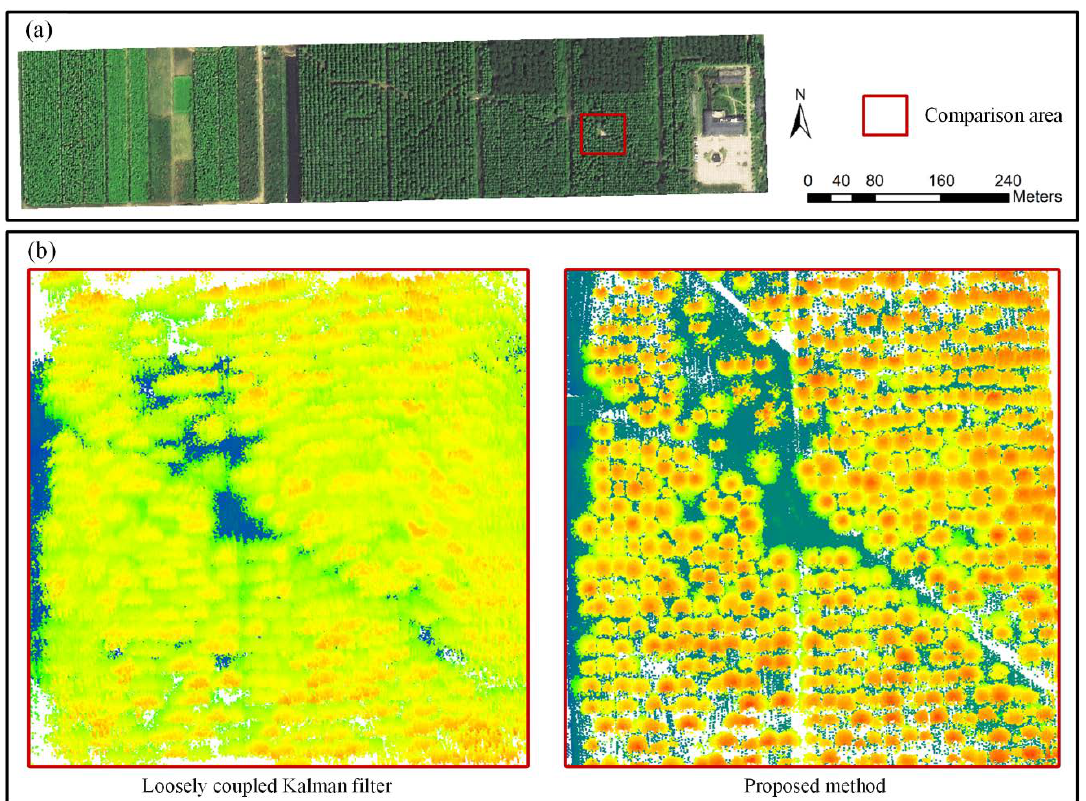
Figure 7. Reconstruction of the optimized point clouds.